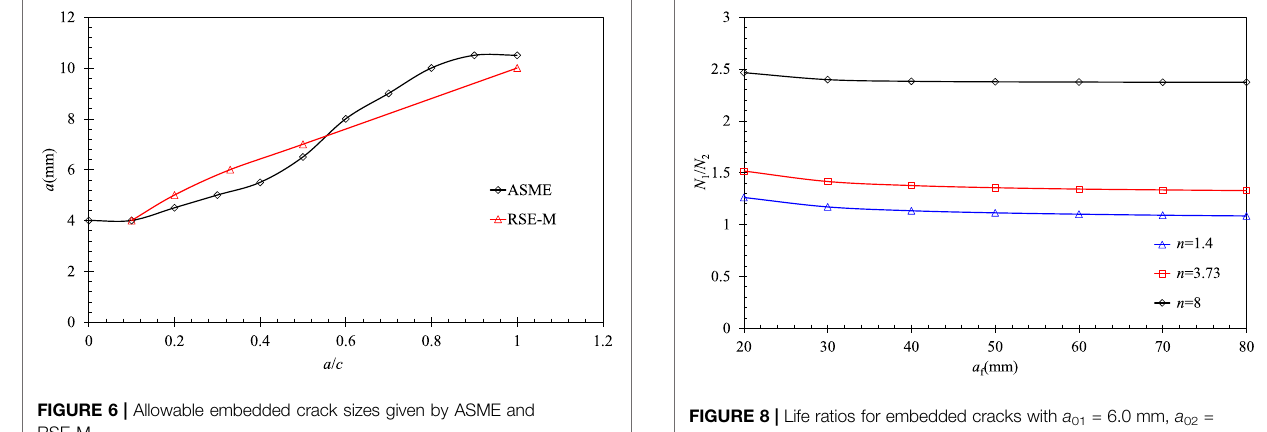
FIGURE 8 | Life ratios for embedded cracks with a 01 (cid:3) 6.0 mm, a 02 (cid:3) 8.0 mm.